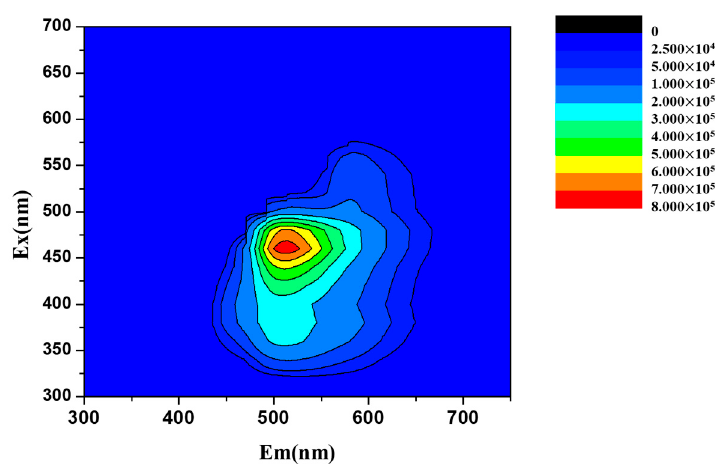
Figure 3. Three-dimensional (3D) photoluminescence spectra of ABMP in ethanol with the concentration of the sample set to 1% ( w / v